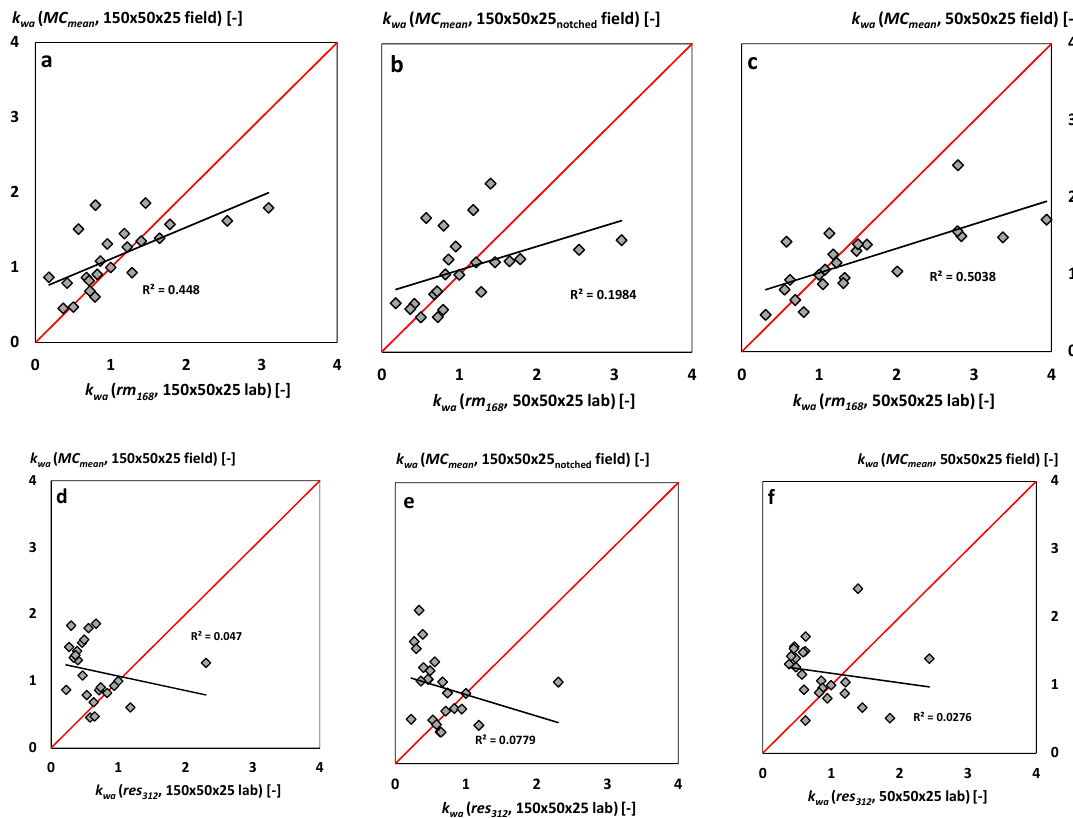
Figure 9. k wa factors based on MC mean (%) measured during outside exposure versus k wa factors of rm 168 ( a – c ) and res 312 ( d – f ) calculated as moisture content (%) in submersion ( a , b , d , e ) and floating tests ( c , f ) according to [5].